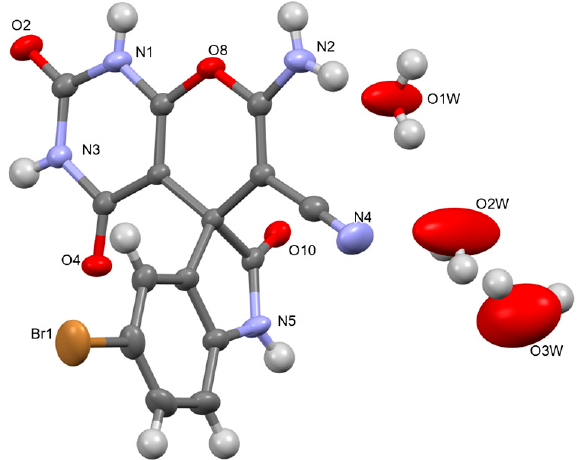
Figure 2. Molecular representation and atomic labeling scheme of spiro compound 1b obtained from single crystal X-ray diffraction technique. O1W, O2W, and O3W refers to the oxygen atoms from the three water molecules co-crystallized with the spiro compound.